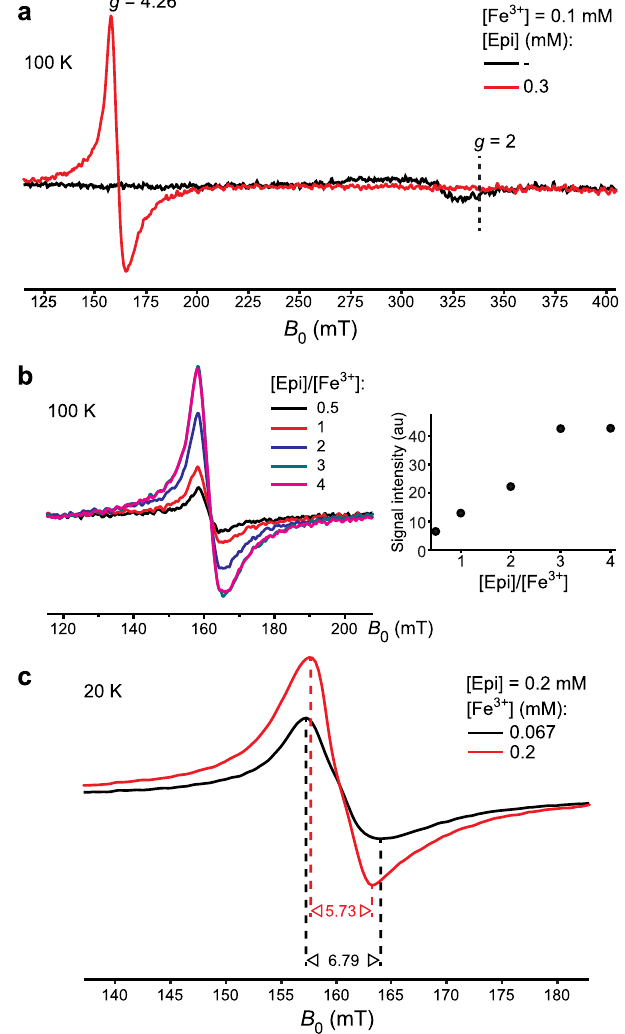
Figure 2. Low-T EPR spectra of Fe 3 + in 10 mM Tris buffer, pH 7.4. ( a ) 100 K EPR spectra of Fe 3 + in the absence or presence of Epi. ( b ) 100 K EPR spectra (left) and the intensity of the g = 4.26 Fe 3 + signal (right) for different [Epi]/[Fe 3 + ]. [Fe 3 + ] = 0.1 mM in all samples. ( c ) 20 K EPR spectra of 0.067 mM and 0.2 mM Fe 3 + in the presence of 0.2 mM Epi. Line-widths are given in mT. All samples were frozen after 15 min incubation at 293